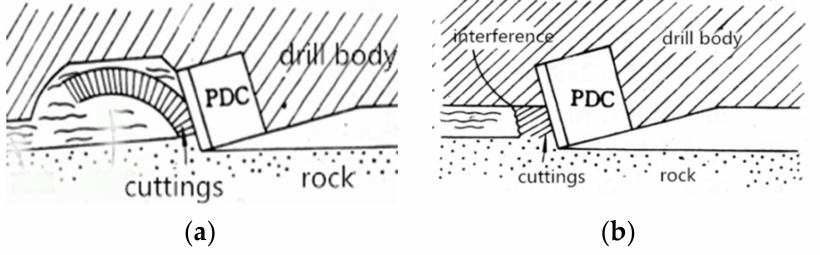
Figure 6. Exposure height of PDC. ( a ) Removal speed reduced by high exposure; ( b ) Flow obstruction by low